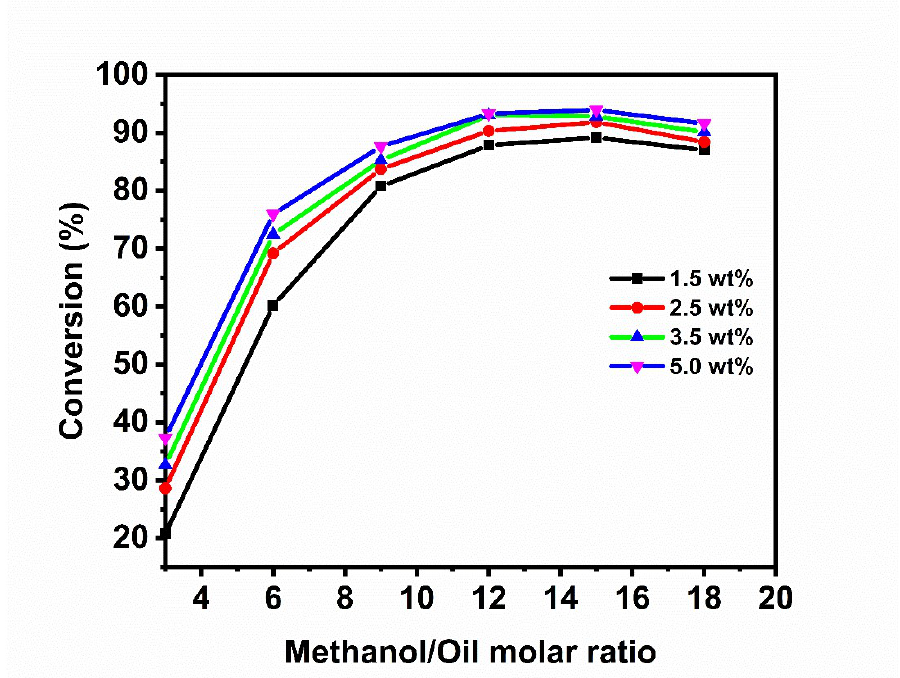
Figure 8. Effect of the molar ratio methanol/waste oil on the biodiesel production at different catalyst Figure 8. E ff ect of the molar ratio methanol / waste oil on the biodiesel production at di ff erent catalyst weight loadings and a reaction temperature of 65 °C. weight loadings and a reaction temperature of 65 ◦